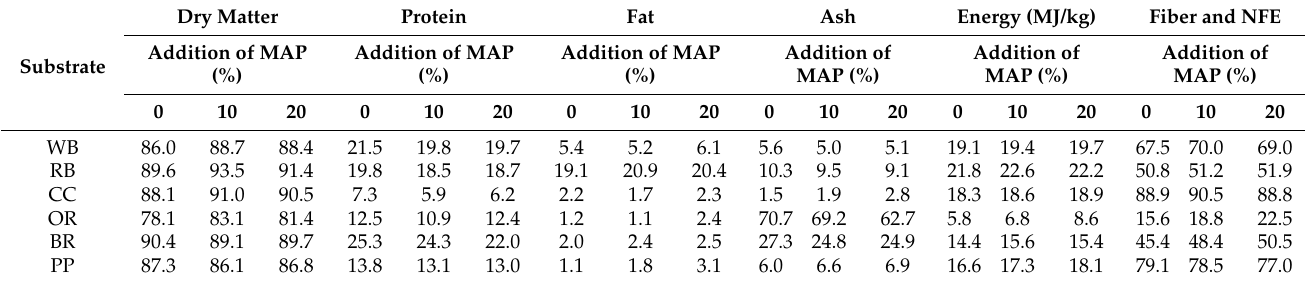
Table 1. Proximate composition of the experimental by-products from agri-food industry used as substrates for Tenebrio molitor oviposition and rearing, supplemented with 0%, 10% or 20% distillation residues of Medicinal Aromatic Plants